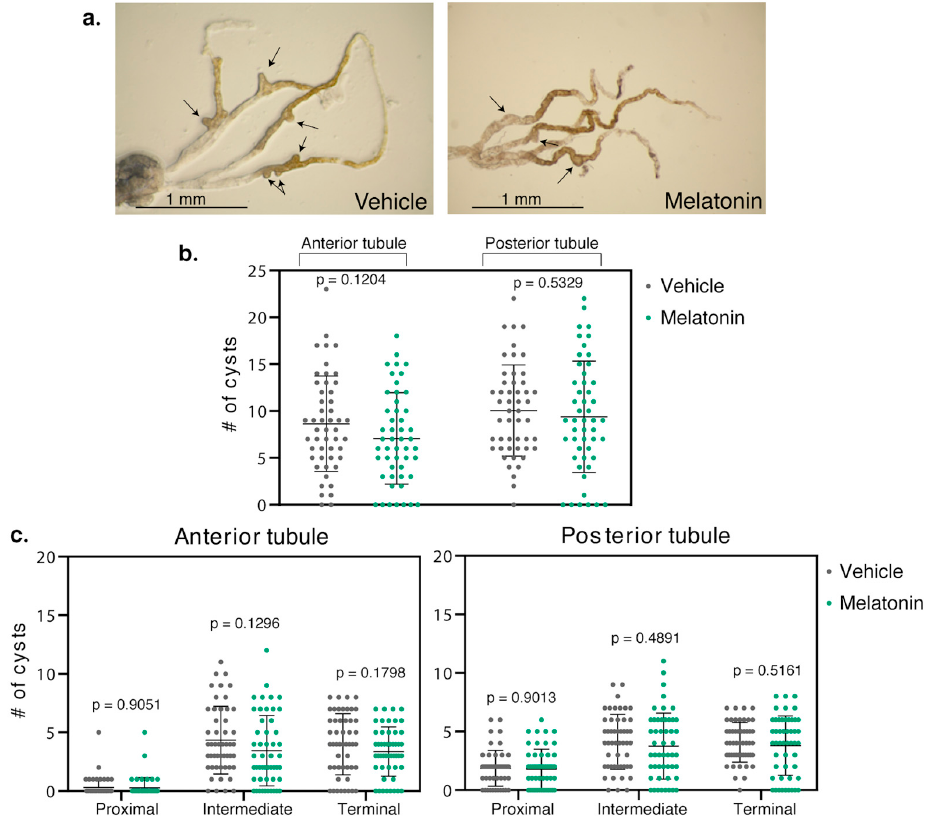
Figure 3. Melatonin did not reduce cysts in BicC ∆ / IIF34 flies. ( a ) Representative Malpighian tubules micro-dissected from BicC ∆ / IIF34 flies treated with either vehicle (ethanol) or 150 µ M melatonin were photographed ex vivo. Arrows indicate exemplary cysts. ( b ) Nested plots reporting overall number